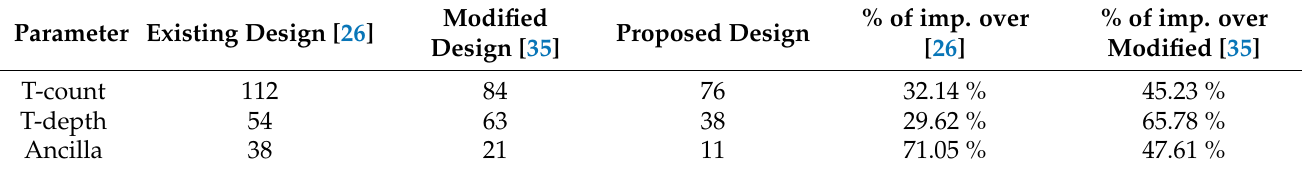
Figure 8. Proposed 4-qubit quantum leading zero detector.The outputs are highlighted. Table 2. Resource utilization of proposed 8 qubit leading zero detector with the existing